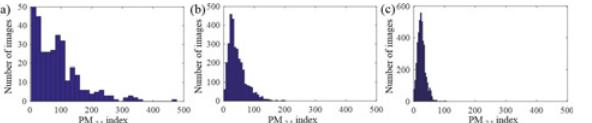
Fig 2. The histogram of PM 2.5 in different cities. (a) Beijing; (b) Shanghai; (c)